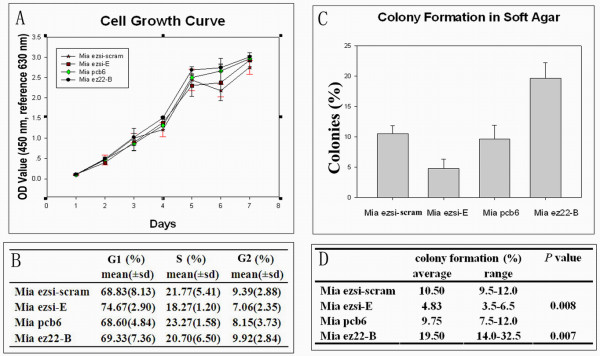
Effects of ezrin on MiaPaCa-2 cell growth and anchorage-independent growth. (A) The cell growth curves of the Mia ezsi-scram, Mia ezsi-E, Mia pcb6 and Mia ez22-B cells were assayed on days 1-7. (B) Flow cytometry assay showing the percentage of different cell cycle phases in the four cell clones. (C) Anchorage-independent growth assay of ezrin-overexpressing and ezrin-silencing cells. The cell growth ability in soft agar of the four cell clones was examined for three weeks. Columns, mean; bars, SD. (D) Statistical analysis of colony formation in the four cell clones. There was a significant difference of the colony formation ability between the Mia ez22-B and the Mia pcb6 cells, as well as between the Mia ezsi-scram and the Mia ezsi-E cells, respectively, shown by x2-test. The results are expressed as the mean ± SD of three independent experiments.